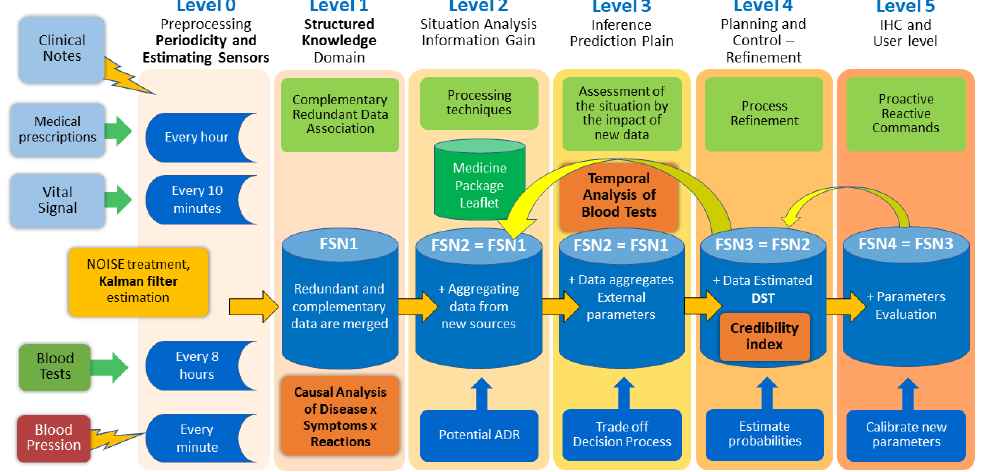
Figure 10. Information fusion big